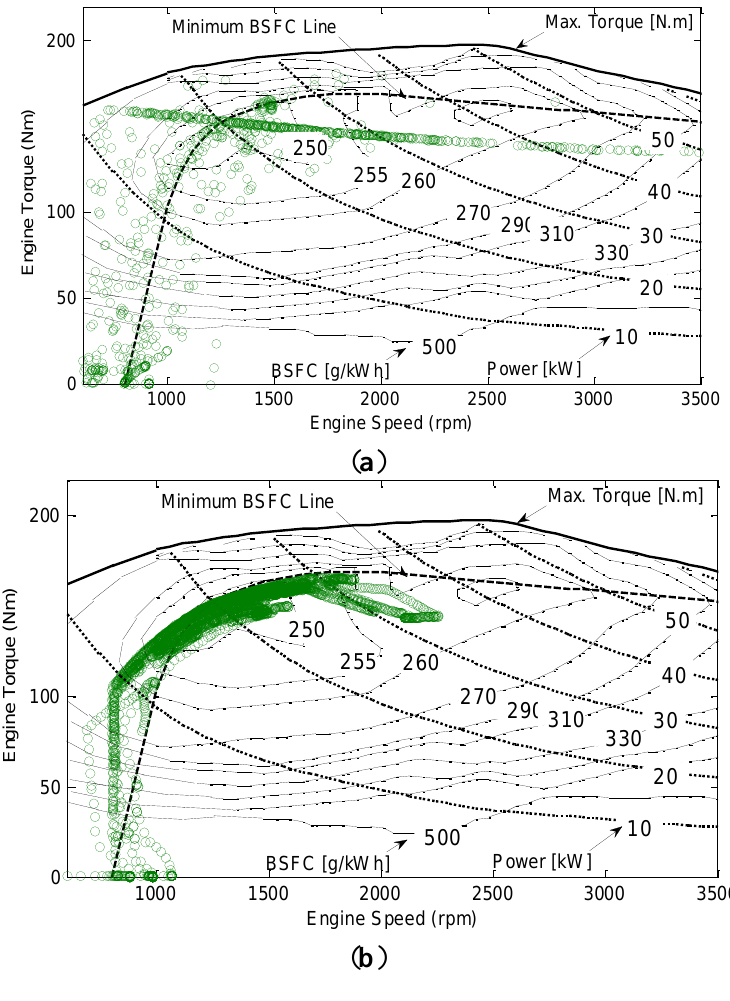
Figure 16. Engine operating points visitation on the BSFC map under HWFET: ( a ) Using the PID-based control system; and ( b ) Using the MPC-based control